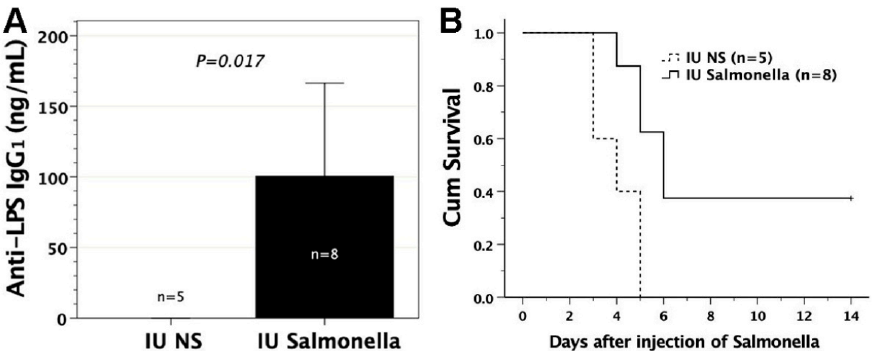
Figure 5. Survival of recipients with in utero exposure to heat-killed Salmonella following postnatal challenge of S. Typhimurium. Gestational day 14 FVB/N fetuses were subjected to intraperitoneal injection of 5 × 10 3 heat-killed S. Typhimurium SL1344 (IU Salmonella ). ( A ) Serum anti-LPS IgG 1 levels were examined at the age of 1 month by ELISA using mouse monoclonal anti-LPS IgG 1 (1E6, Abcam) as the standard curve. Recipients with IU Salmonella significantly generated anti-LPS IgG 1 . ( B ) At the postnatal age of 6–8 weeks, the recipients were challenged intraperitoneally with 10 5 live S . Typhimurium. IU Salmonella compared favorably in survival to mice receiving in utero saline injection (IU NS, p = 0.011). LPS,